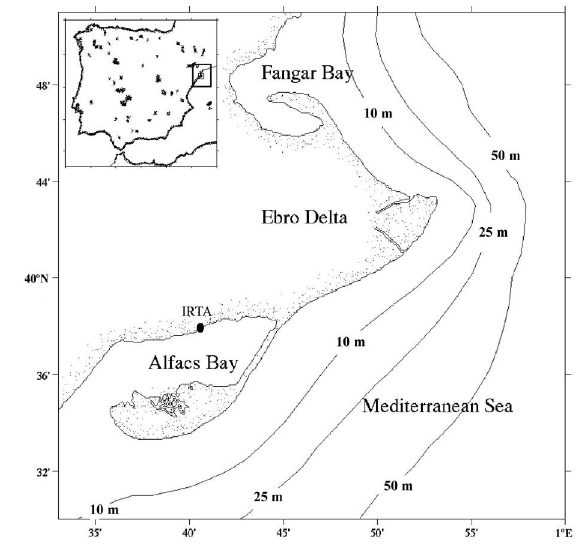
Fig . 1. – Map of the Ebro Delta showing the site (IRTA, Alfacs Bay) at which the experiments were